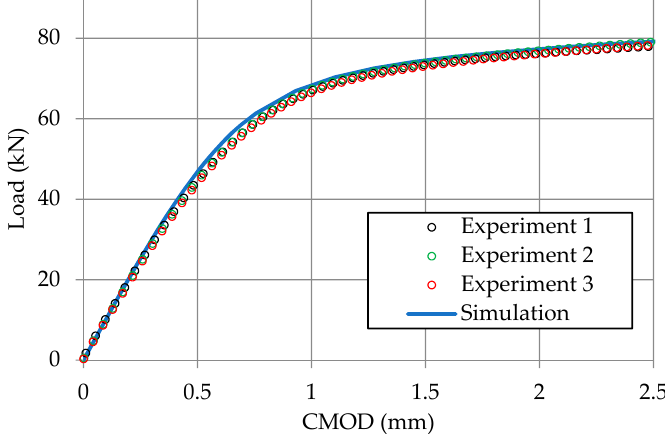
Figure 6. Experimentally and numerically determined tension load vs. CMOD curves for as-received steel P91 at room temperature.